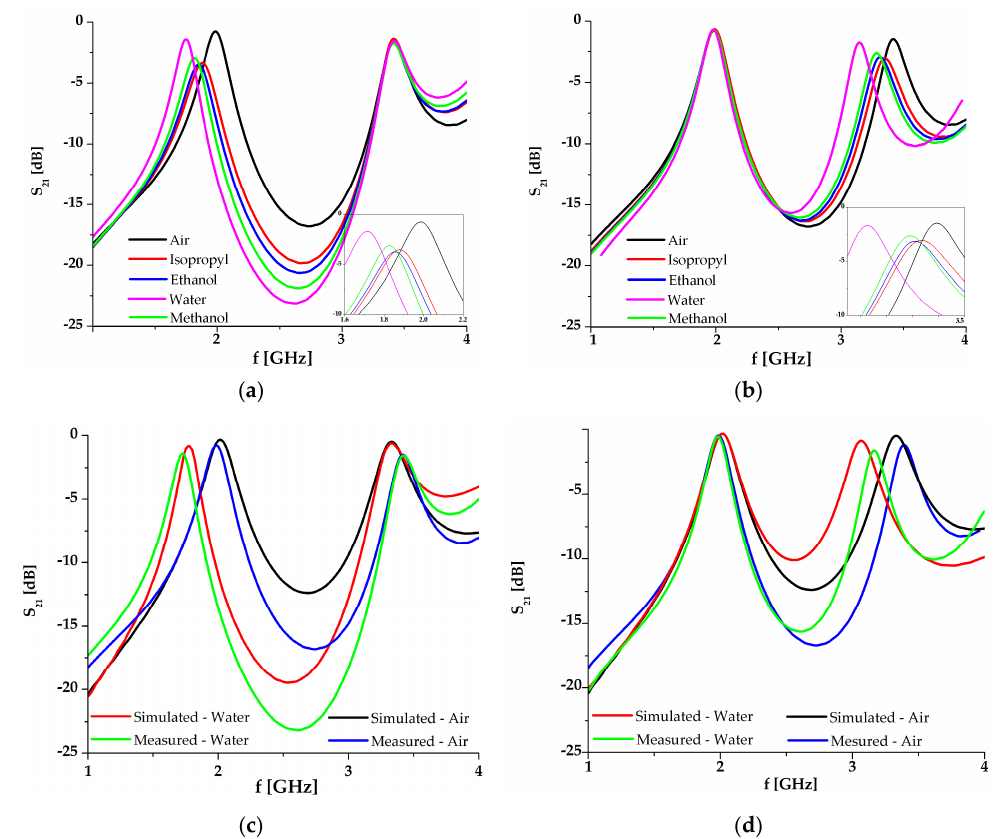
Figure 10. ( a ) Measurement results of the proposed sensor with different fluids placed in channel 1, whilst channel 2 is filled with air; ( b ) Measurement results of the proposed sensor with different fluids placed in channel 2, whilst channel 1 is filled with air; ( c ) Comparison of the simulation and measurement results for channel 1; ( d ) Comparison of the simulation and measurement results for channel 2. Sensors 2017 , 17 , 2713